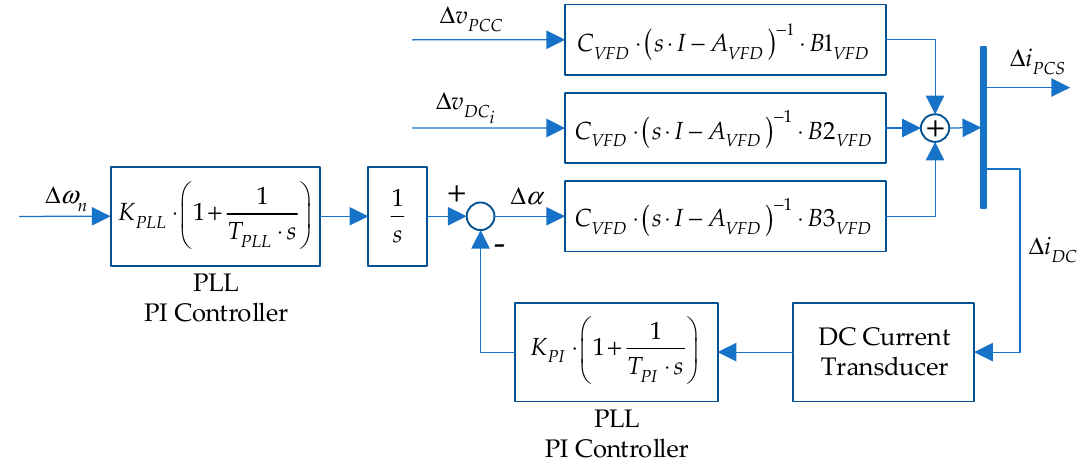
Figure 5. Control scheme of the TVFD first stage.